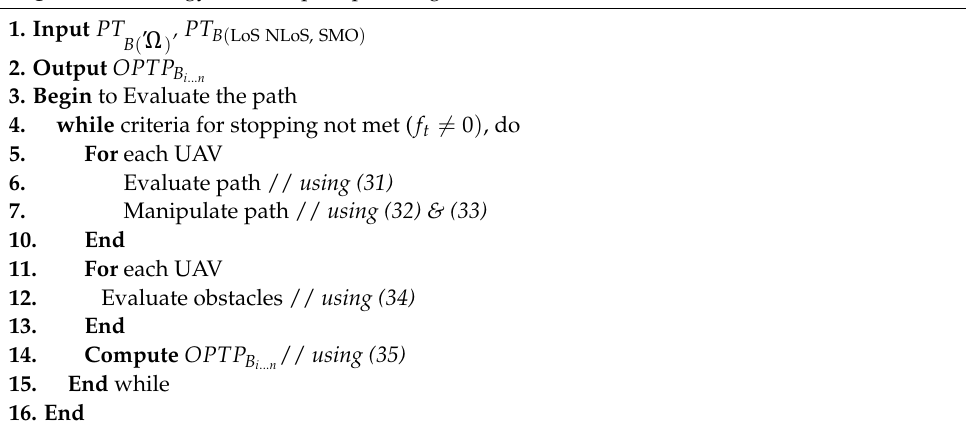
Algorithm 4 Energy-efficient path planning.